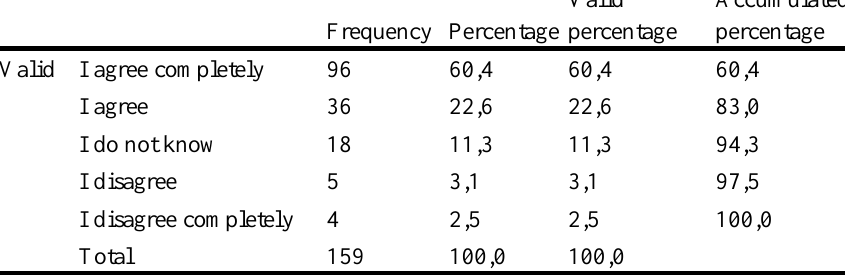
Valid percentage questionnaires´ results, question 10 “Students really appreciate bilingual